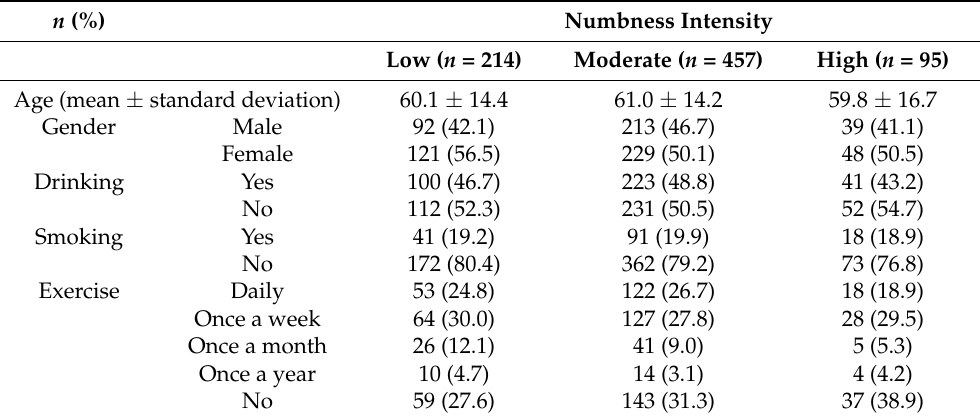
Table 2. Patient background by numbness intensity in 768 people who are currently experiencing numbness without